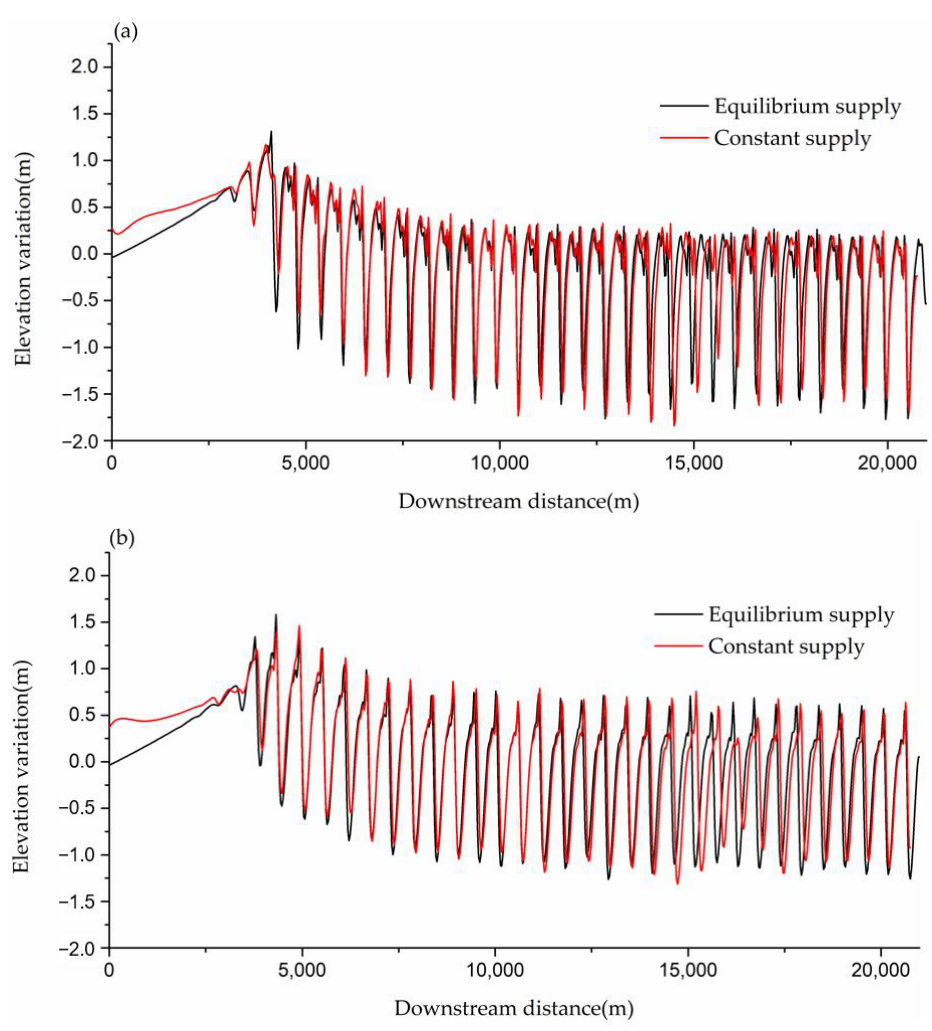
Figure 5. Elevation variation comparison at the right bank in both runs after removing the phase difference: ( a ) At lowest discharge. ( b ) At peak discharge.